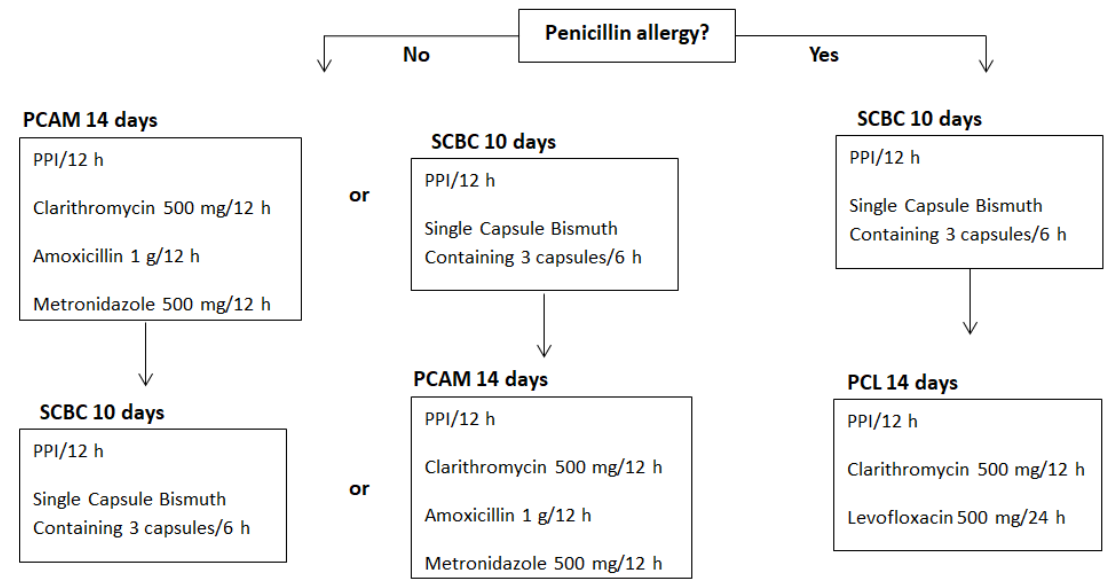
Figure 4. Algorithm of treatment based on the IV Spanish Consensus Conference on Helicobacter pylori infection treatment and consensus protocols of national scientific societies of gastroenterology and primary care physicians [8,20]. PPI: proton pump inhibitor. Modified from: Adrián Gerald McNicholl, Javier Amador Romero, Xavier Calvet